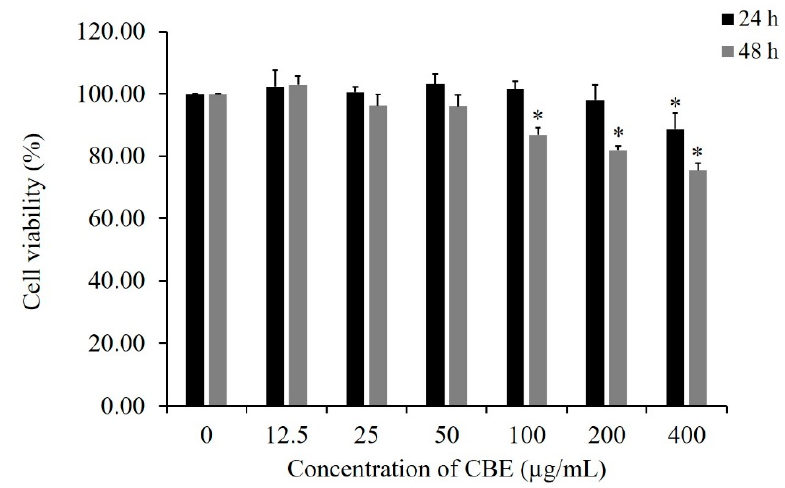
Figure 1. Effect of CBE on cell viability in LoVo cells. Cells were treated with CBE for 24 and 48 h and cell viability was determined using MTT assay. Results are presented as mean values ± SD ( n = 3). * p < 0.05 versus the control group. CBE, Cinnamomum bejolghota extract; SD, standard deviation.